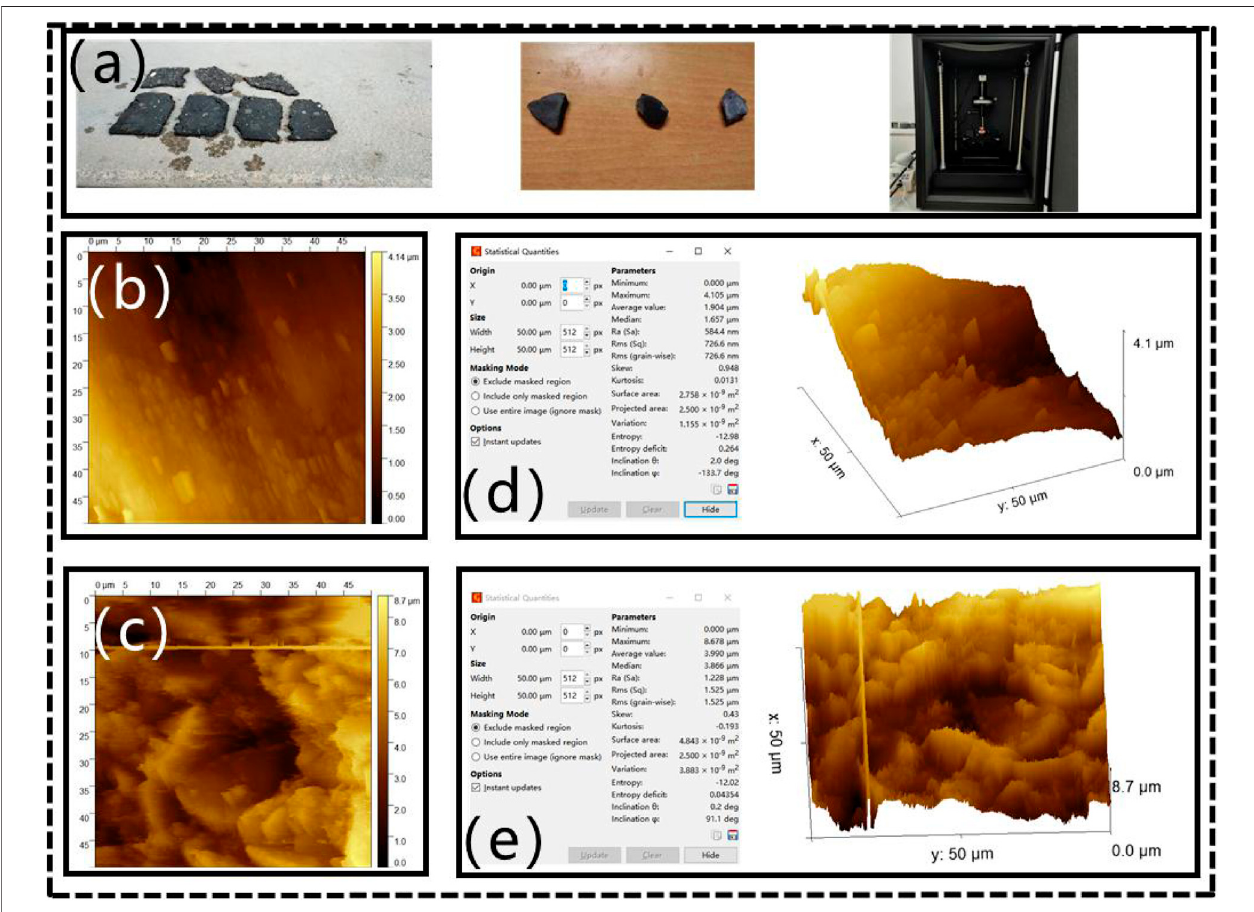
FIGURE4| Microscopictests: (A) testpreparation; (B) specimenafter60 daysofwaterimmersion; (C) specimenafter120 daysofwaterimmersion; (D) scanning area and surface area of steel slag aggregates before water immersion; and (E) scanning area and surface area of steel slag aggregates after immersion.